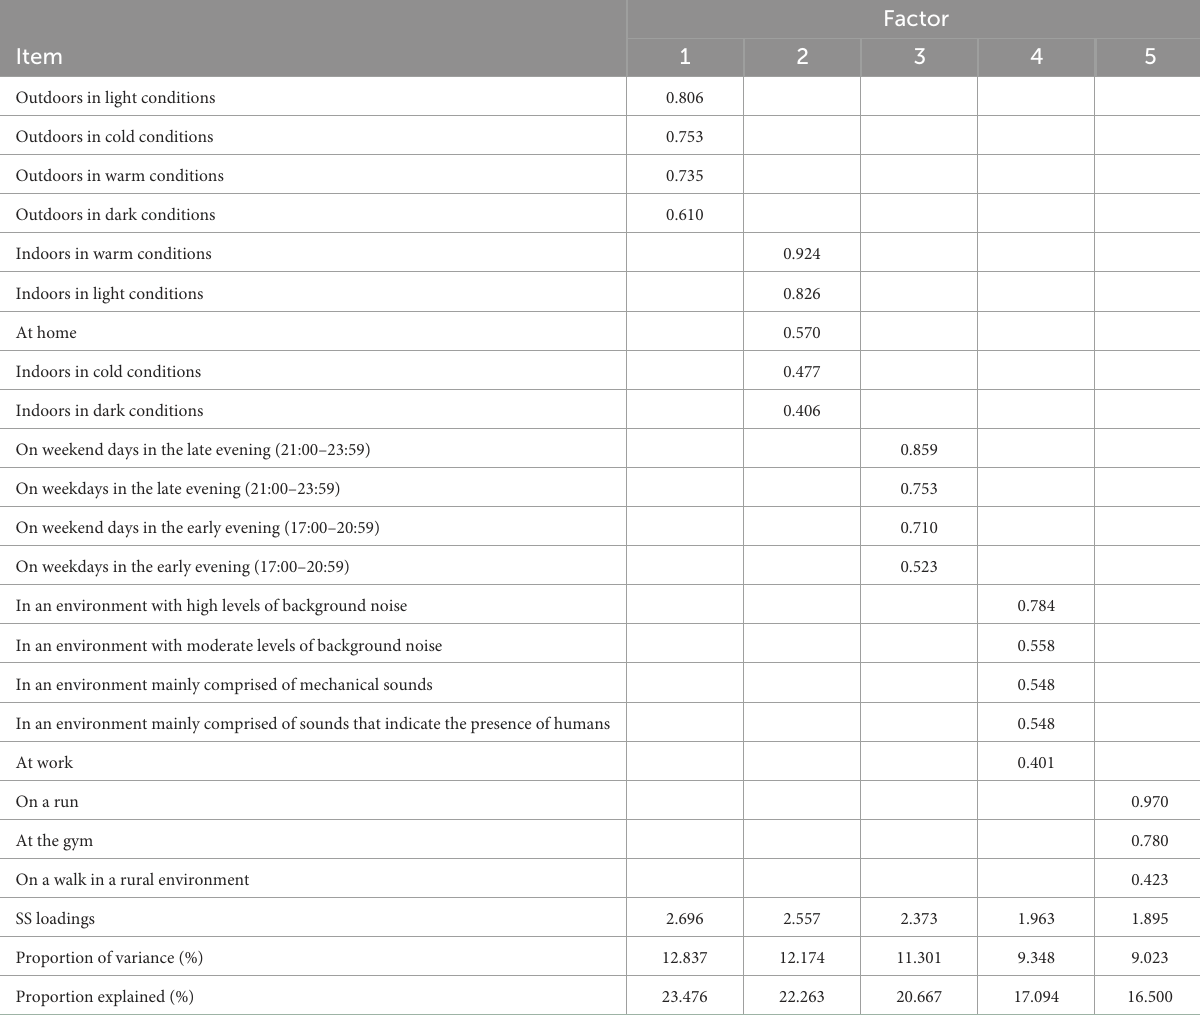
TABLE 1 Factor loadings for the EFA with direct quartimin rotation of the retained “environment context attentional engagement podcast listening”